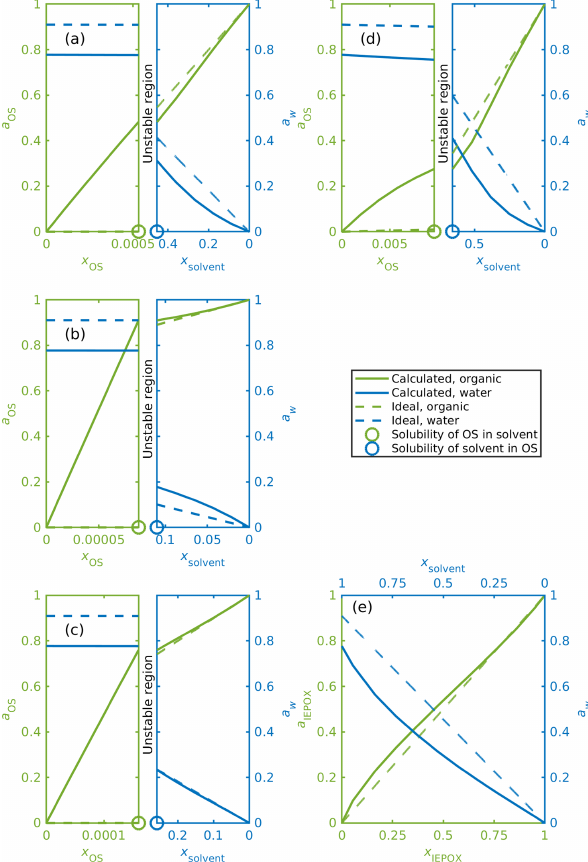
Figure 7. Activities for OS, IEPOX and water in ternary aqueous mixtures. The solvent is a 0.09 mole fraction ammonium bisulfate solution, and the ideal water activity is equal to the mole fraction of water; (a) α -pinene-OS-5, (b) β -pinene-OS-1, (c) limonene-OS- 1, (d) isoprene-OS-2, (e) δ 1 -IEPOX. The left-hand sides of panels (a–d) show the solvent-rich phase, and the right-hand sides show the organic-rich phase. The ABS-to-water ratio is kept constant in all calculated mixing states, which means that ammonium bisulfate and water are not individually at equilibrium at the solubility